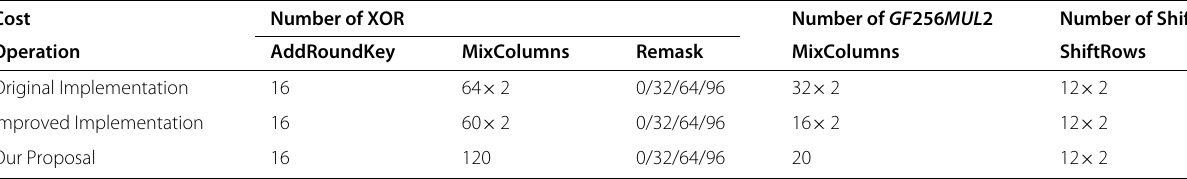
Table 2 Comparison of the costs on linear operations of one round Cost